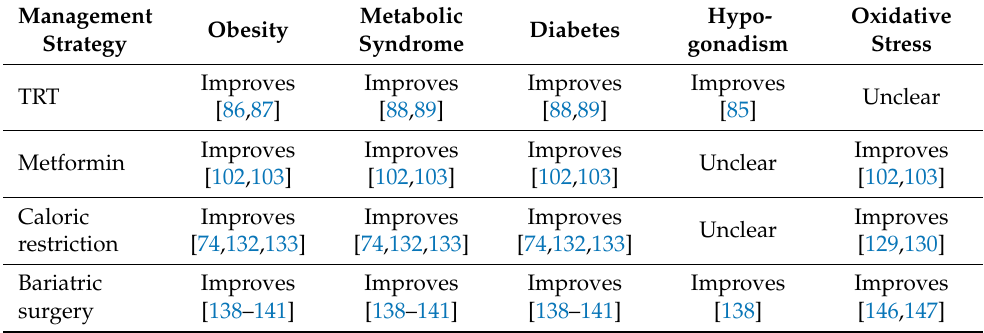
Table 2. A summary comparison of testosterone-replacement therapy (TRT), metformin, caloric re- striction, and bariatric surgery impact on obesity, metabolic syndrome, hypogonadism, and oxidative